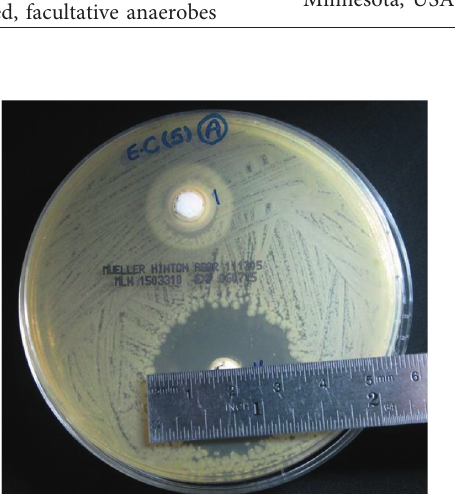
Figure 1: Measuring the inhibition zone using a metal